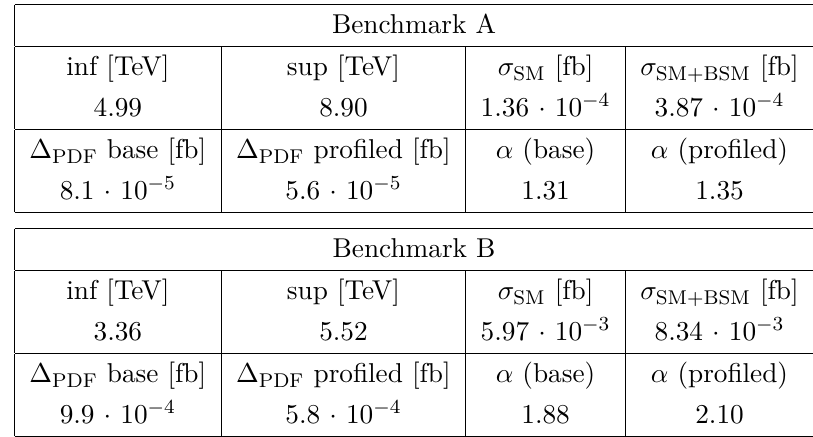
Figure 4 . Number of events as function of the di-lepton invariant mass for benchmark A (left) and benchmark B (right) with 3000 fb − 1 of integrated luminosity.